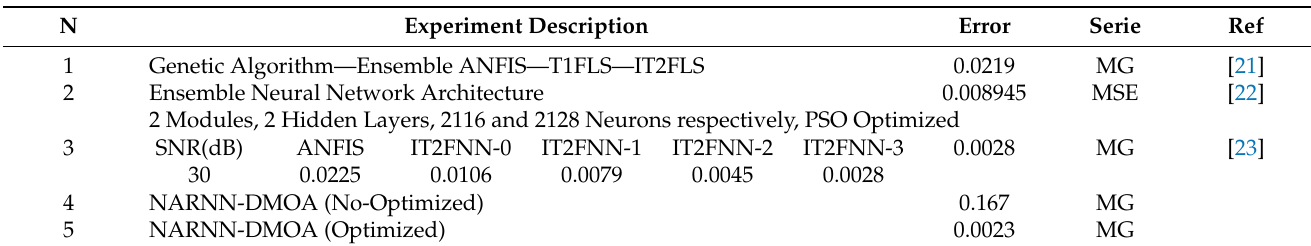
Genetic Algorithm—Ensemble